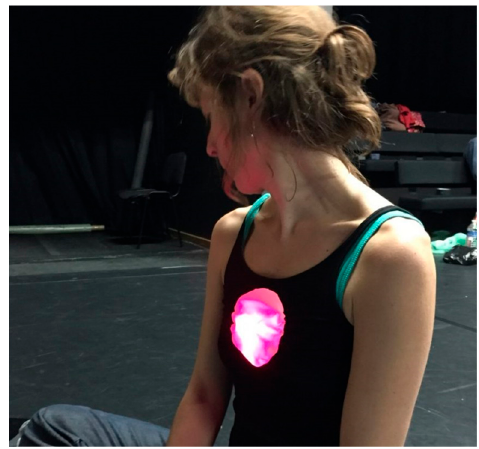
Figure 2. Light and dance t-shirt. Photo: Jeanne Bloch ©.